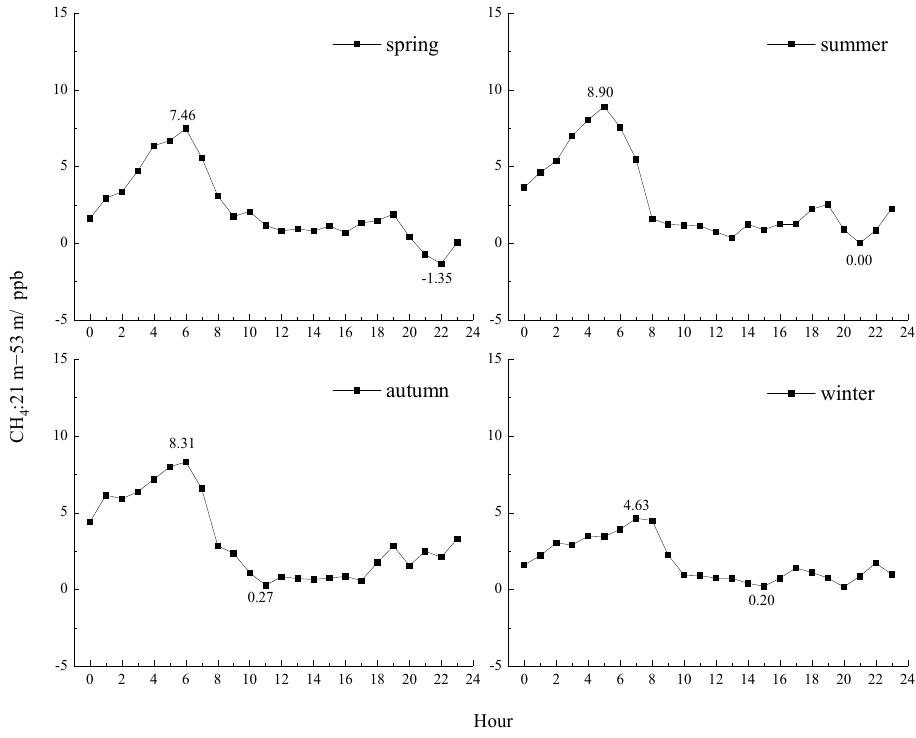
Figure 2. Difference in hourly CH 4 concentration in different seasons at the Lin’an station.